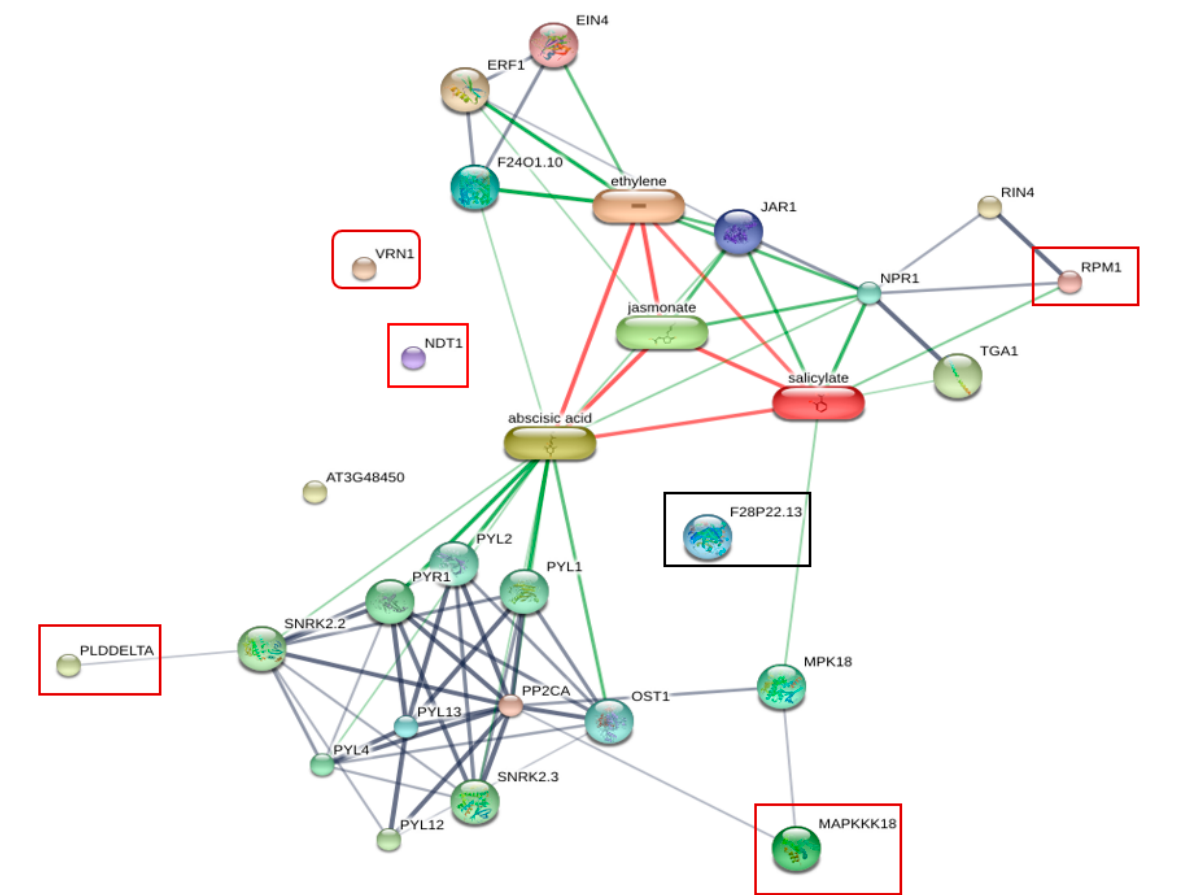
Figure 5. Protein interaction network generated by STITCH 5.0 displaying the association between six phosphoproteins identified from resistant plants inoculated with R. solanacearum and plant hormones. RPM1 showed strong association with SA through NPR1 in the protein network. Phospholipase D delta (PLDDELTA) and MAP3K showed associations with abscisic acid. Nicotinamide adenine dinucleotide transporter 1 (NDT1), cinnamyl alcohol dehydrogenase 1 (CAD1 or F28P22.13), and VRN1 showed no network interaction.